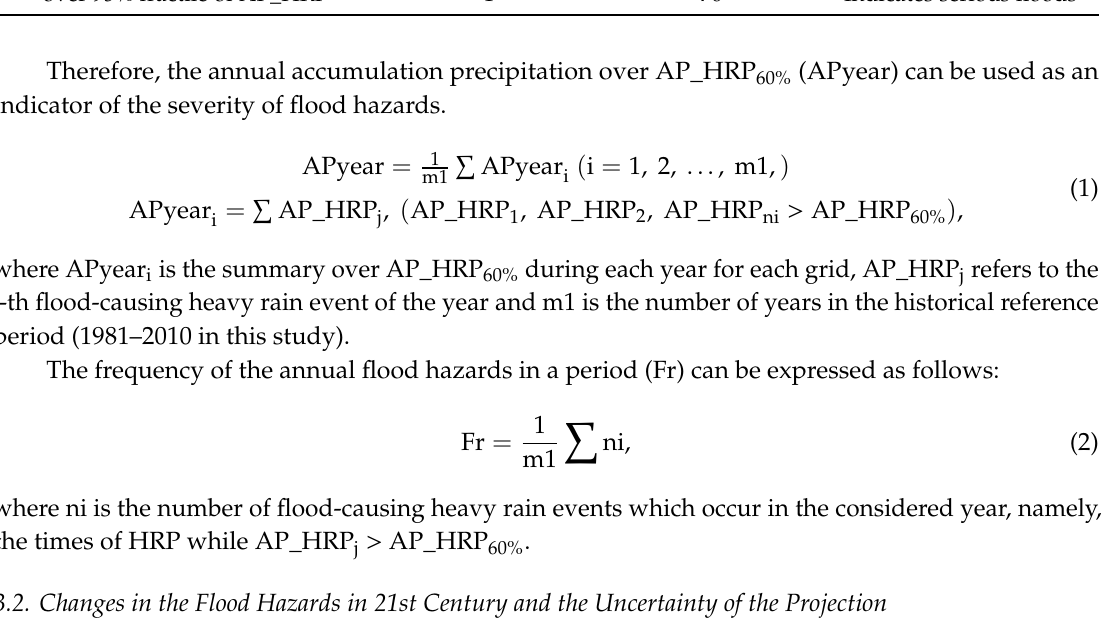
Table 2. The average error magnitude of AP_HRP for reported flood events in China (2001–2010). Flood Days Reported by AP_HRP Vacancy Rate (%) Missing Rate (%) Remarks Total AP_HRP 135 2 over 60% fractile of AP_HRP 18 8 Indicates floods over 80% fractile of AP_HRP 10 34 76 Indicates serious